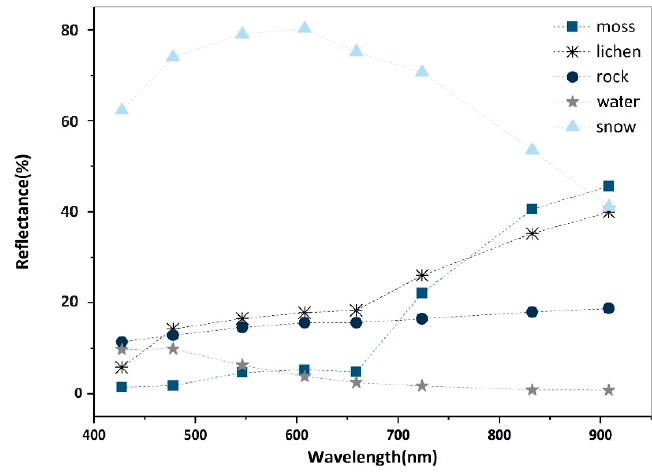
Figure 6. Five endmembers collected in the study area.